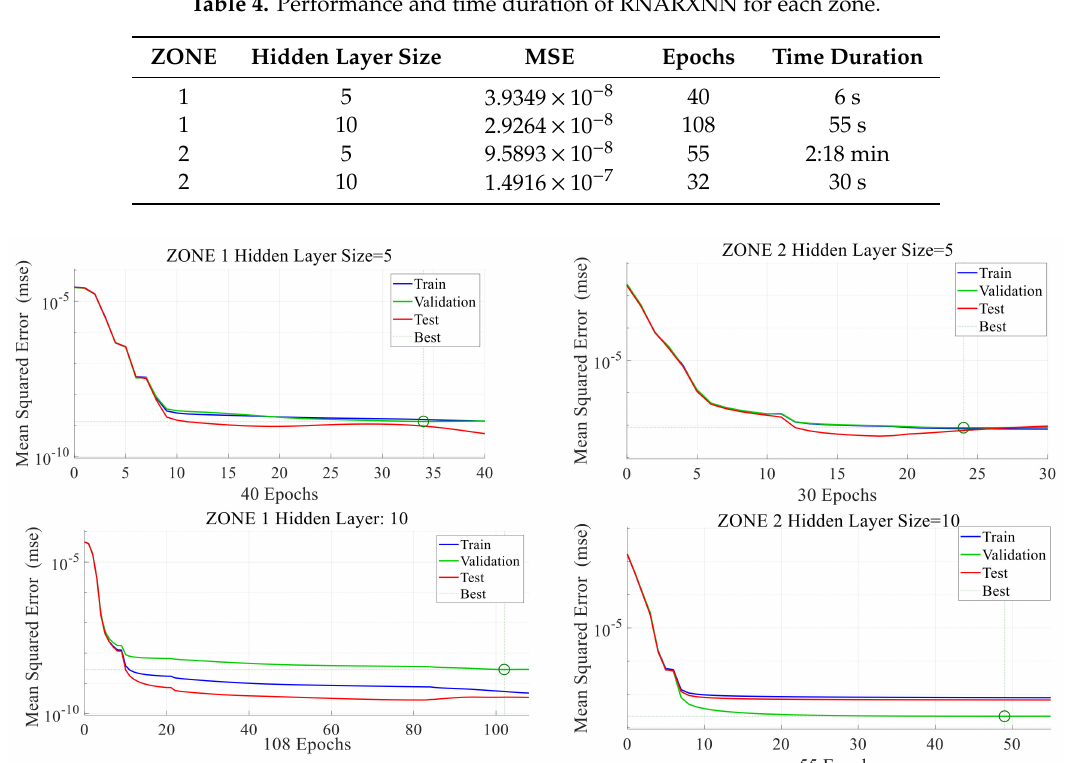
Table 4. Performance and time duration of RNARXNN for each zone.